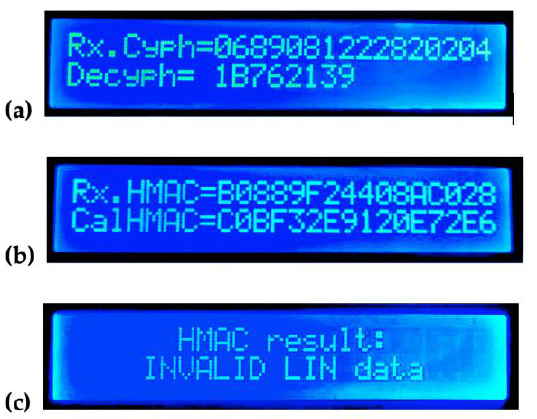
Figure 20. Master node’s state after the attacked response; ( a ) decryption result; ( b ) HMAC result; ( c ) LIN data validity result.